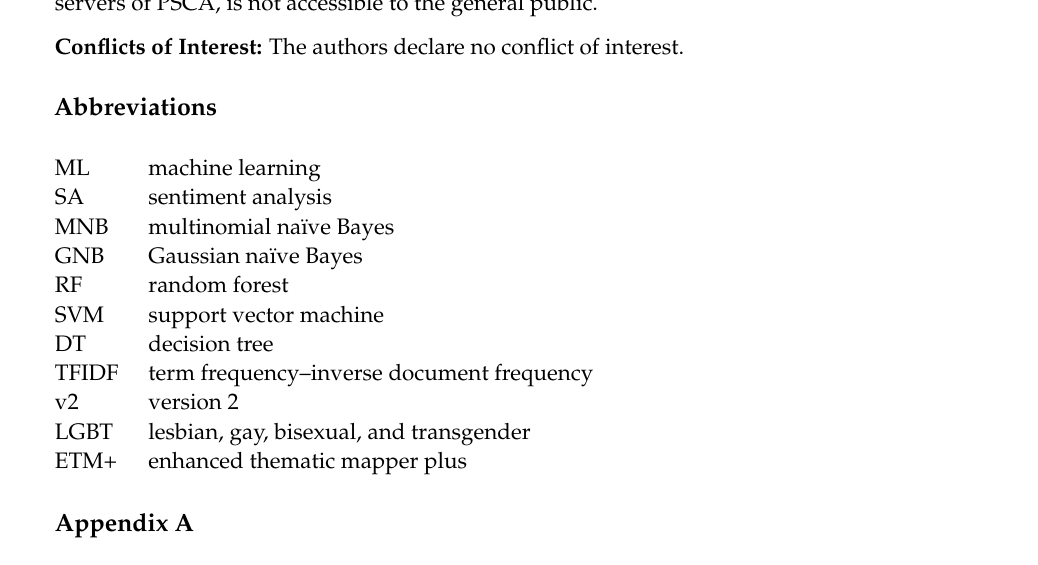
Table A1. English and Roman Urdu Stop Word.